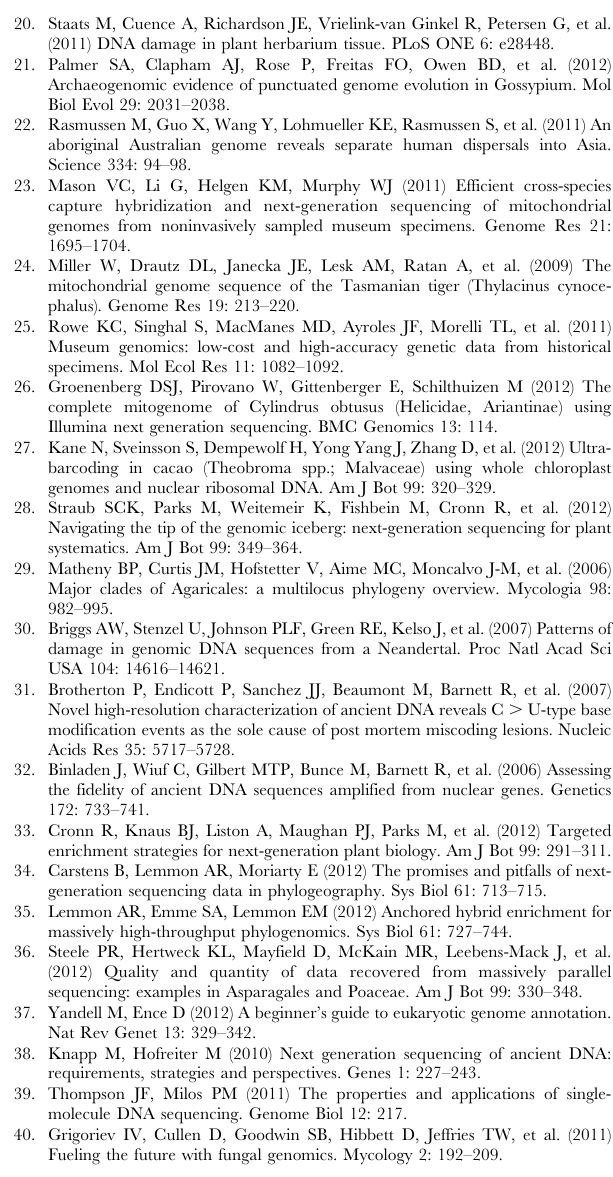
Table S6 Best BLASTx hits of CDS regions with high number of SNPs or